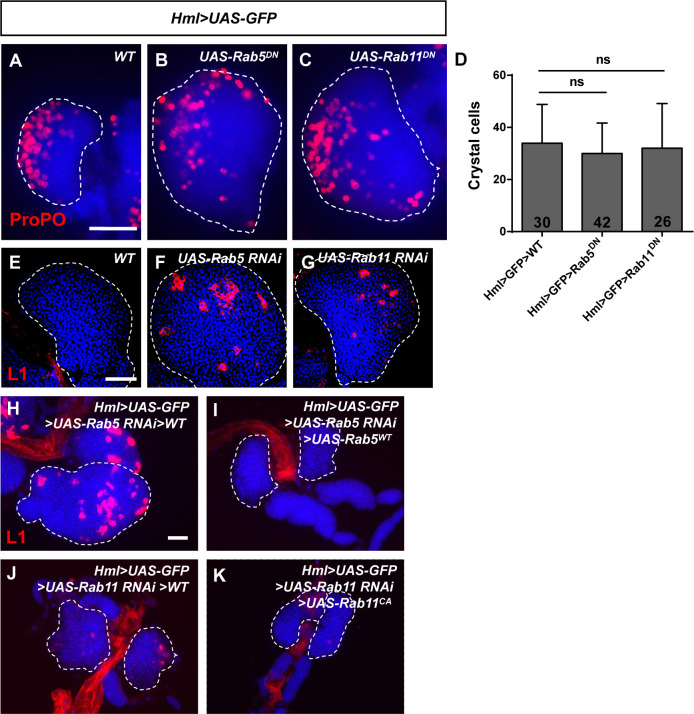
Analysis of the crystal cell count and rescue assays of lamellocyte differentiation in lymph glands.(A–D) The crystal cell count (as evaluated by anti-ProPO staining) was unchanged in lymph glands upon the inactivation of Rab5 or Rab11. (E–G) Aberrant lamellocyte formation was observed in Hml>UAS-GFP>UAS-Rab5/11 RNAi lymph glands. (H–K) The aberrant lamellocyte differentiation was rescued in Hml>UAS-GFP>UAS-Rab5 RNAi>UAS-Rab5WT and Hml>UAS-GFP>UAS-Rab11 RNAi>UAS-Rab11CA lymph glands. ns, not significant. Scale bar: 50 μm.